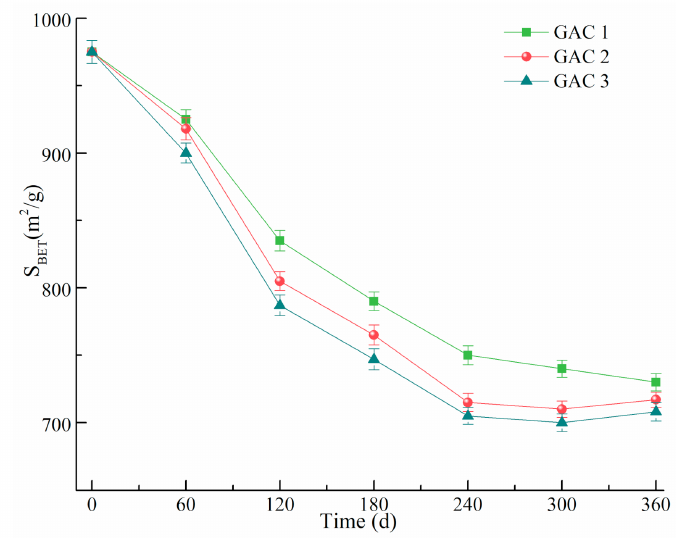
Figure 3. Specific surface area of granular activated carbon (GAC) in different carbon